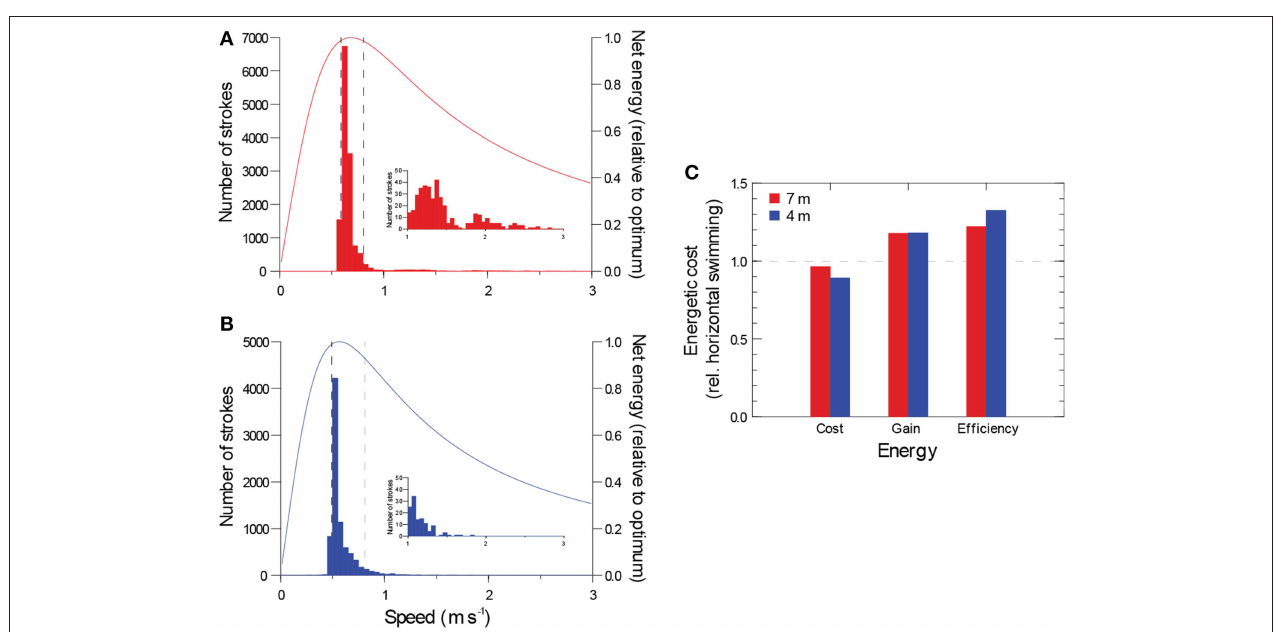
FIGURE 4 | (A, B) Distribution of active swimming speeds for two whale sharks with the theoretical relationship between net energy while foraging for a hypothetical fish swimming constantly and horizontally (from Weihs, 1975). Insets show right tail of each distribution. Bars show number of strokes for a given swimming speed. Broken lines enclose central 90% of all strokes. (C) Estimated locomotor cost, gain in foraging volume, and net foraging efficiency achieved by diving relative to horizontal swimming (horizontal swimming =